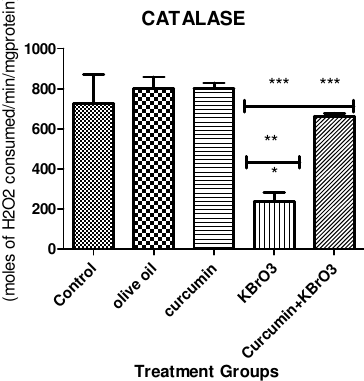
Fig. 4. Effect of curcumin on the activities of superoxide dismutase (SOD) in KBrO3-induced liver oxidative damage. Data are presented as the mean ± SD (n = 6). * values are significantly (p<0.05) different from control, **values are significantly (p<0.05) different from curcumin+ KBrO3, ***values are significantly (p<0.05) different from curcumin. For details, see legend in Table